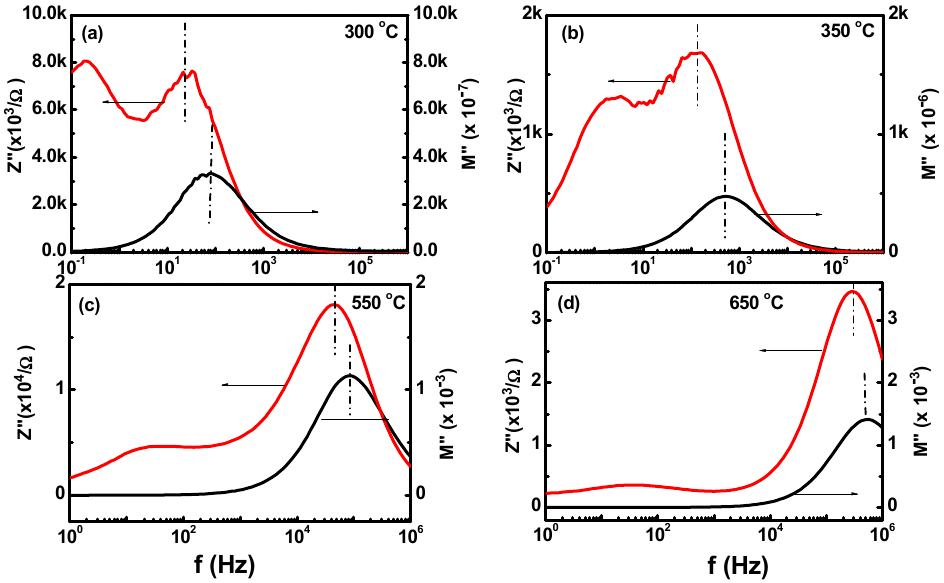
Figure 9. Comparison between Z ″ and M ″ for Fe-substituted PMN-32PT ferroelectric crystal at different temperatures ( a ) 300 °C; ( b ) 350 °C ； ( c ) 550 °C and ( d ) 650 °C.